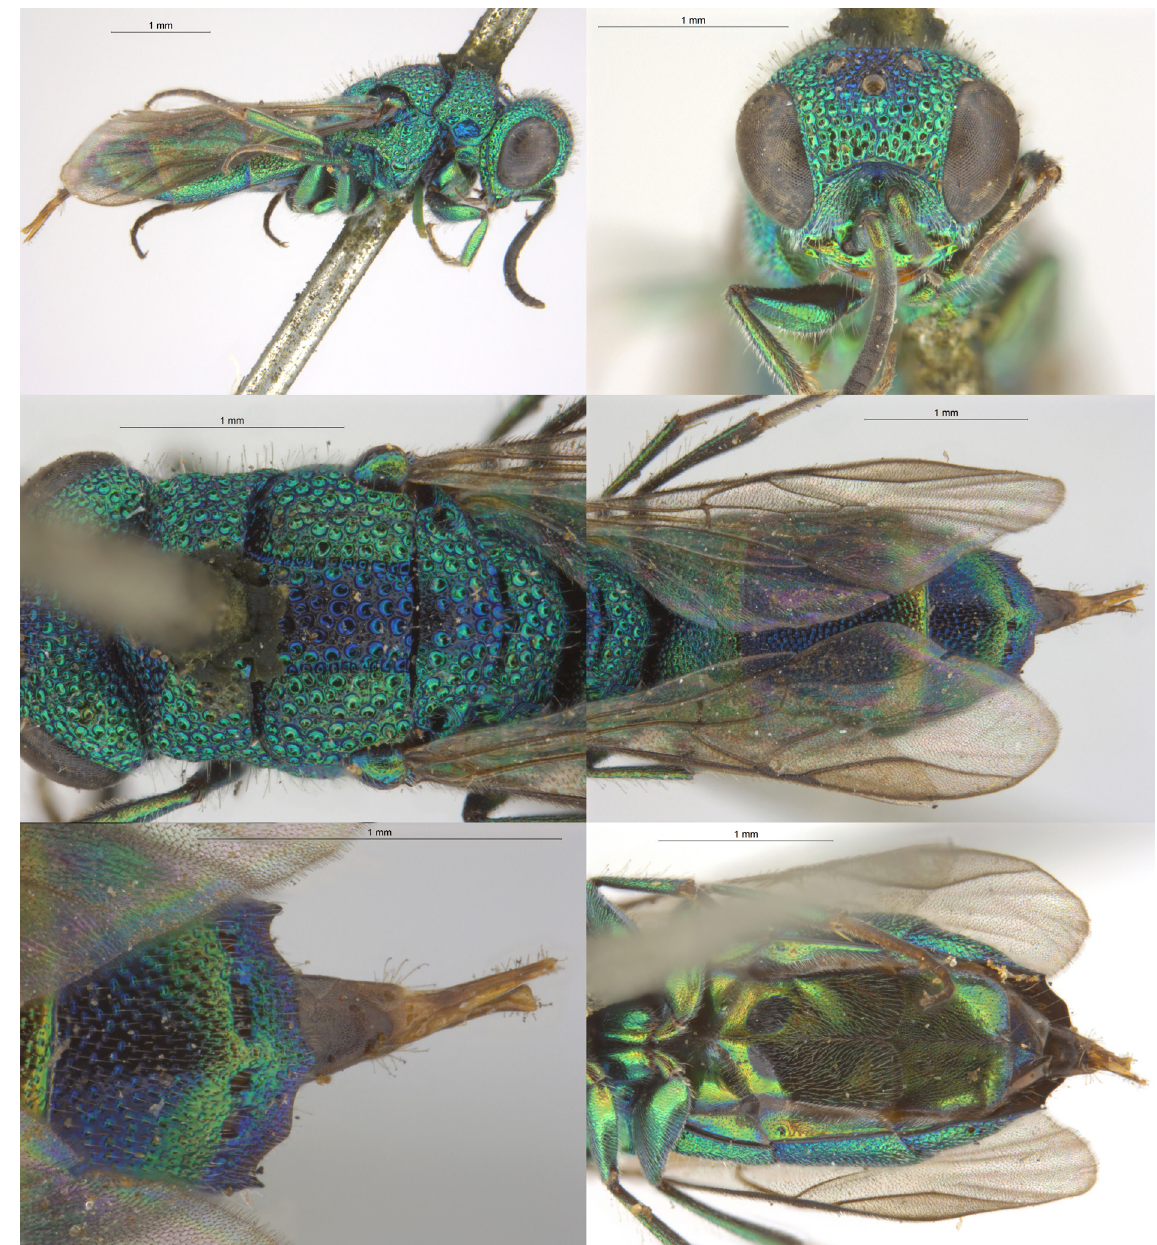
Fig. 8. Chrysidea mendicalis (Cameron, 1897), ♀, holotype (OUMNH). A . Habitus, lateral view. B . Head, frontal view. C . Mesosoma, dorsal view. D . Metasoma, dorsal view. E . T3, posterior view. F . Metasoma, ventral